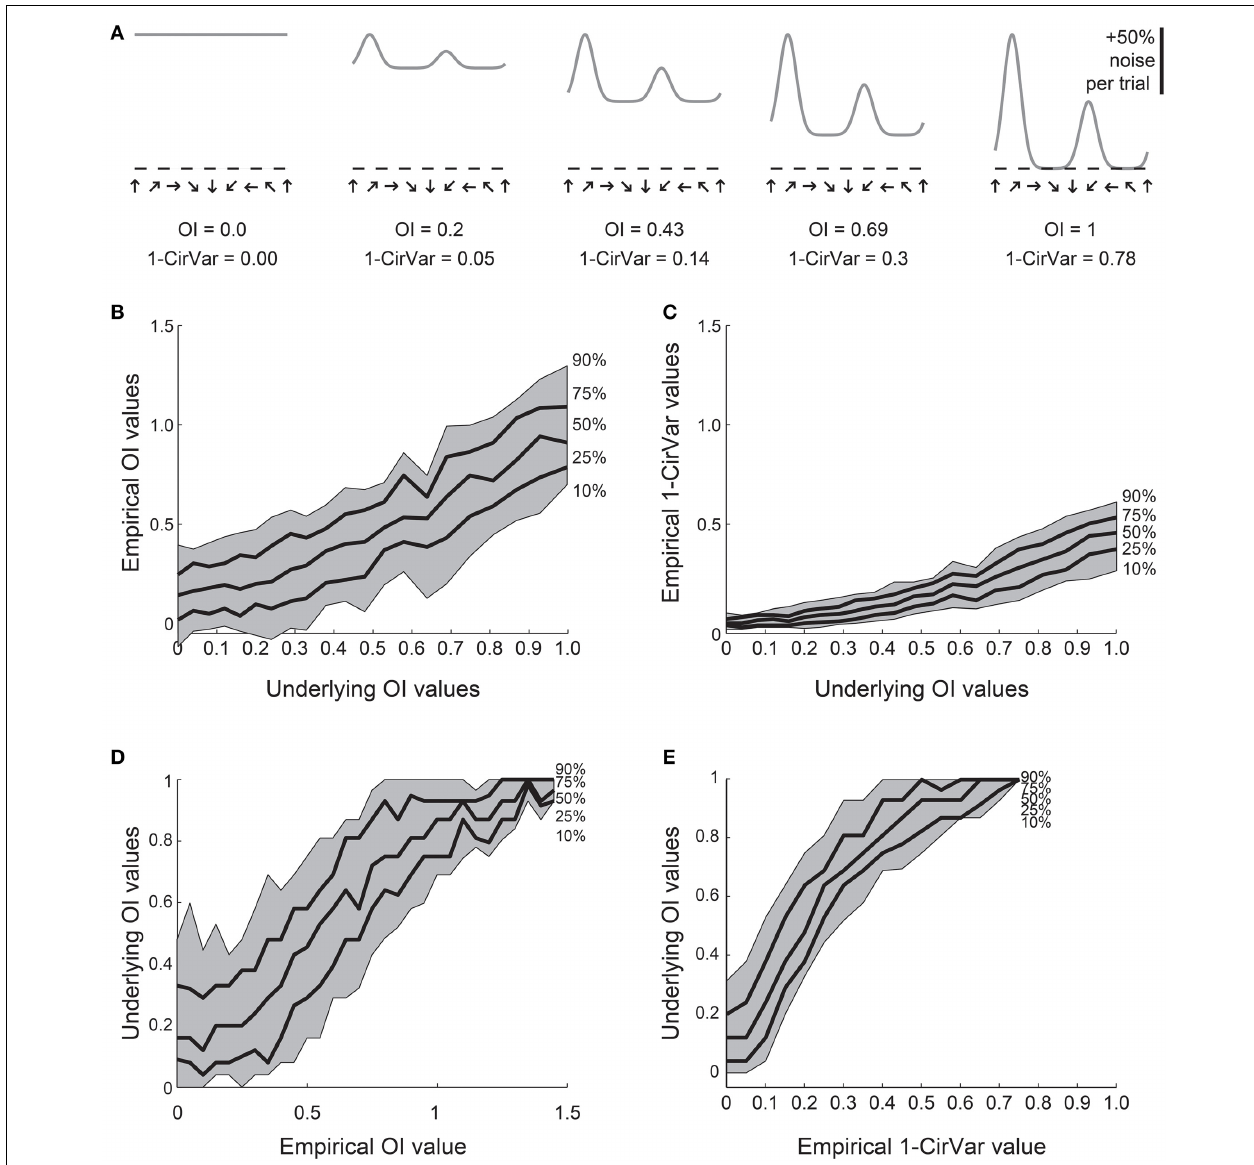
FIGURE 4 | Comparison of OI and circular variance measures for simulated data. We created 100 simulations of tuning curves for each of 21 underlying “true” tuning curves, ranging from OI = 0 to OI = 1, some shown in (A) . Each trial had 50% noise added. (B) Percentiles of the empirically determined OI for the 100 simulations at each underlying “true” OI value. Note that for cells with 0 true selectivity, the empirical OI values range from slightly negative to almost 0.5. (C) Percentiles of the empirically determined 1- CirVar index for each of the underlying “true” OI values. Note that when “true” OI is low, the 1- CirVar is always low. The index 1- CirVar increases as “true” OI increases but the range of values remains narrower than the